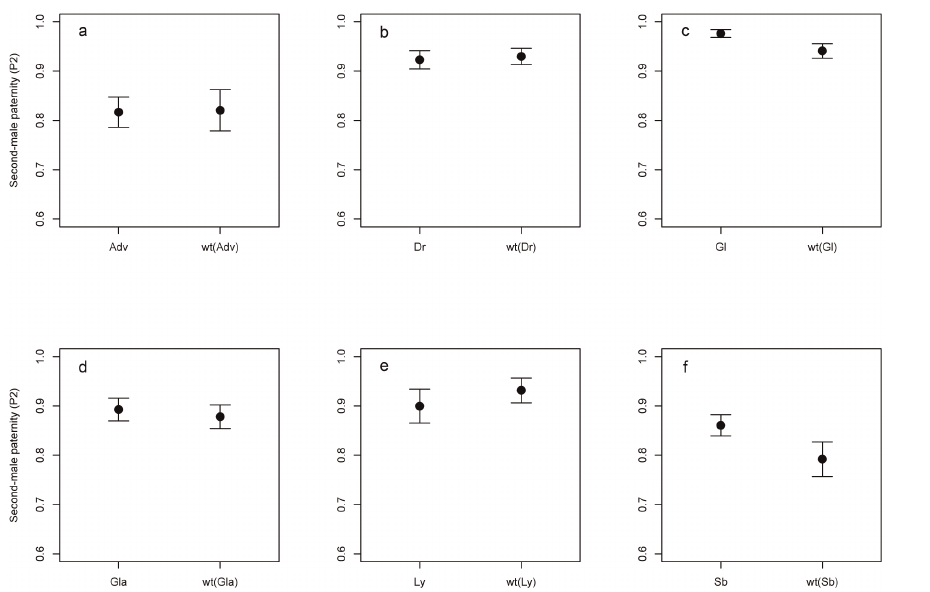
Figure 2. Relative offensive sperm competition success, given as second-male paternity (P2; mean + / 2 SE), for mutant and wild- type males (a. Adv ; b. Dr ; c. Gl ; d. Gla ; e. Ly ; f. Sb ). Wild-type treatments are listed as wt(M i ), where M i represents the paired mutant treatment. Sperm competition success was measured as in Fig. 1. There were no significant differences between mutants and wild-types for any of the paired comparisons.